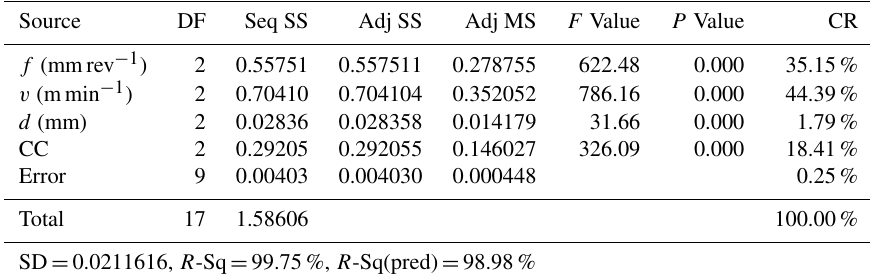
Table 6. ANOVA for Wear rate R .